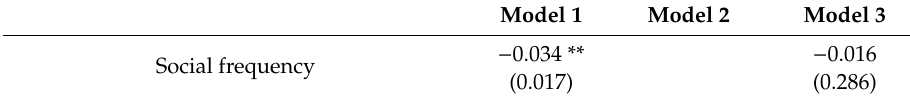
Table 5. Impact of social interaction on private pro-environmental